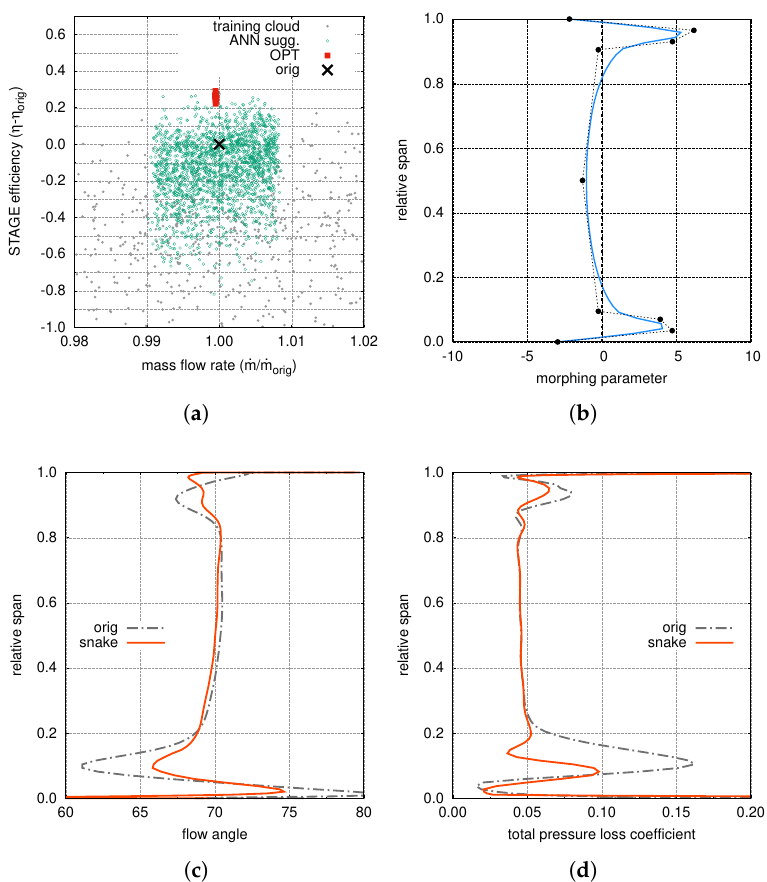
Figure 5. Results of the “snaked” blade design: ( a ) optimization clouds; ( b ) morphing parameter distribution along the span; ( c ) swirl angle distribution for the original and the optimized stator; ( d ) spanwise distribution of the rotor total pressure loss coefficient.